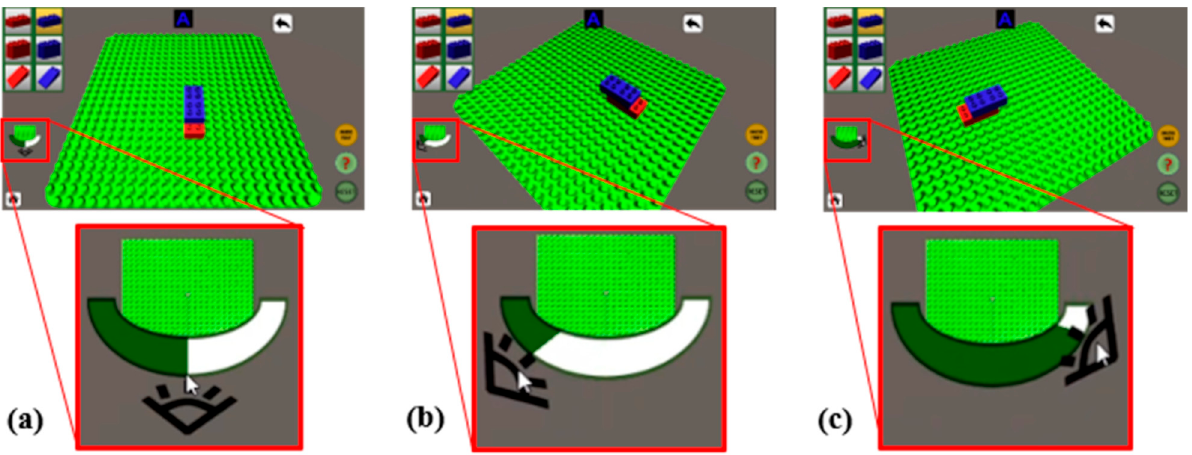
Figure 6. Slider used to change the camera point of view: ( a ) default camera orientation, ( b ) left rotation of the camera point of view, and ( c ) right rotation of the camera point of view.